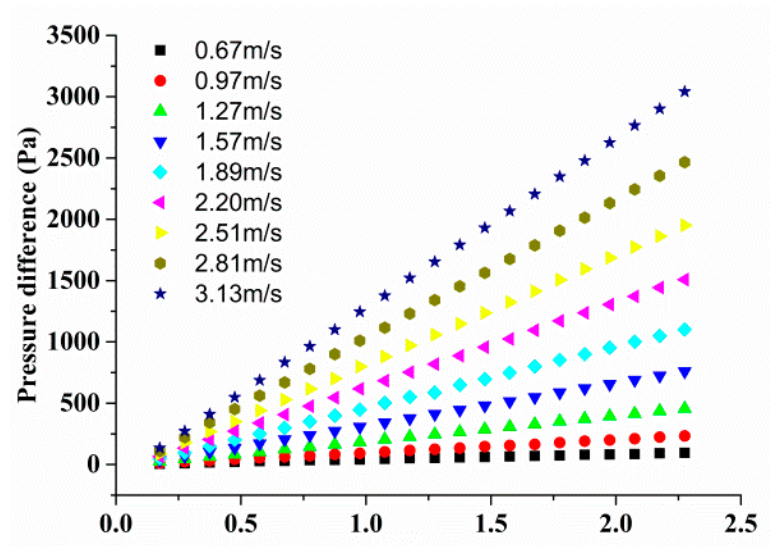
Figure 6. Pressure difference with various velocities.